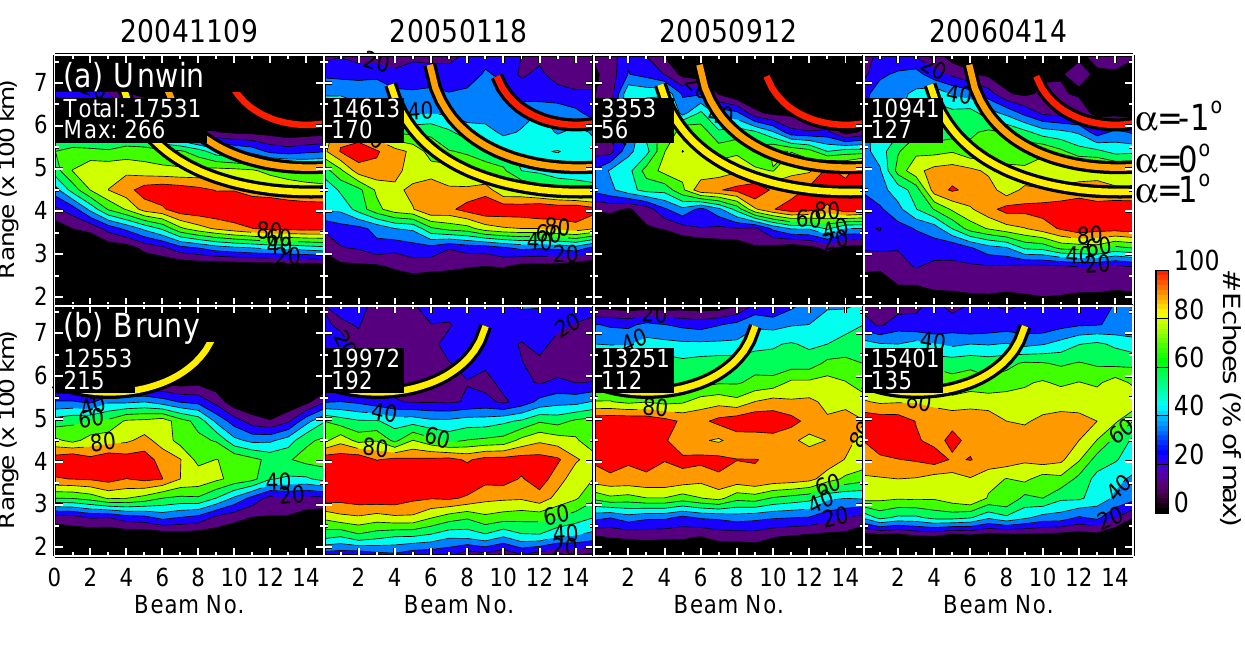
Fig. 5. Same as Fig. 4, but for the (a) Unwin and (b) Bruny Island data restricted to specific storm events in the evening sector. The date for each event is indicated at the top of each column. Constant geometrical aspect angle lines α =− 1 ◦ , 0 ◦ , and + 1 ◦ are also